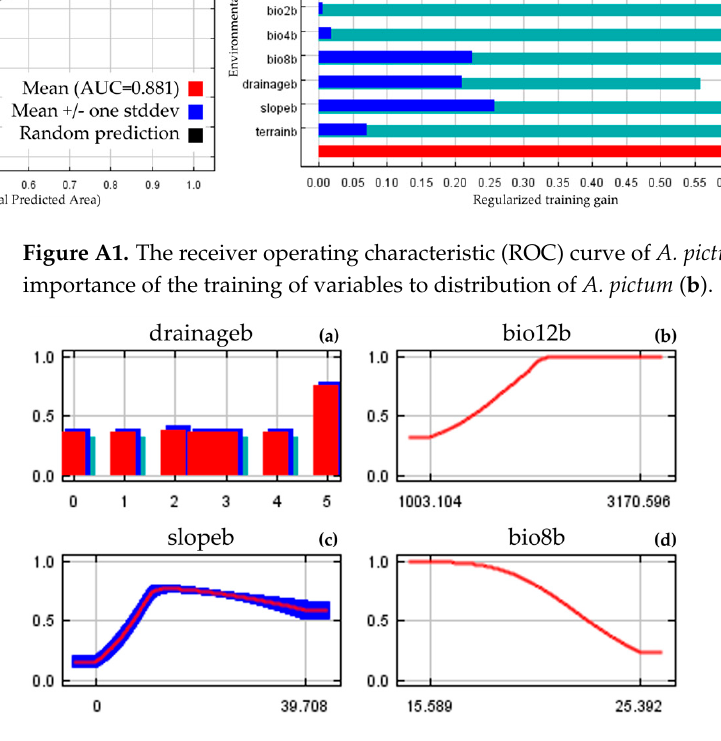
Figure A1. The receiver operating characteristic (ROC) curve of A. pictum ( a ); the Jackknife tests the importance of the training of variables to distribution of A. pictum ( b ).